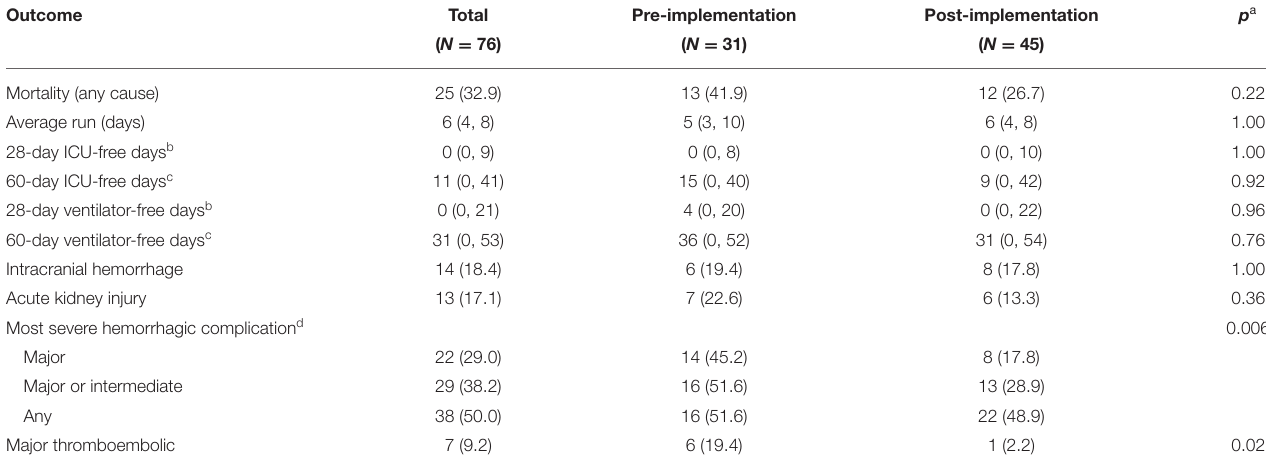
TABLE 3 | Outcomes and complications.